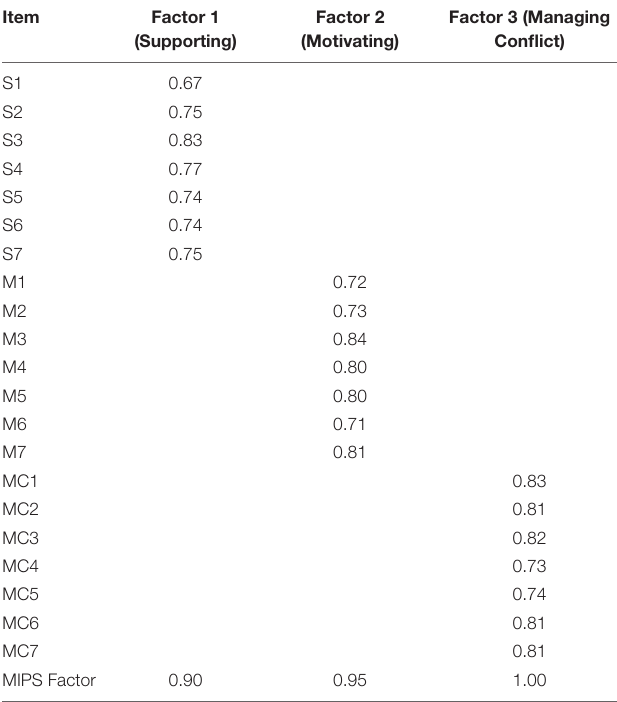
TABLE 4 | Study 3: Confirmatory Factor Analysis Loadings.